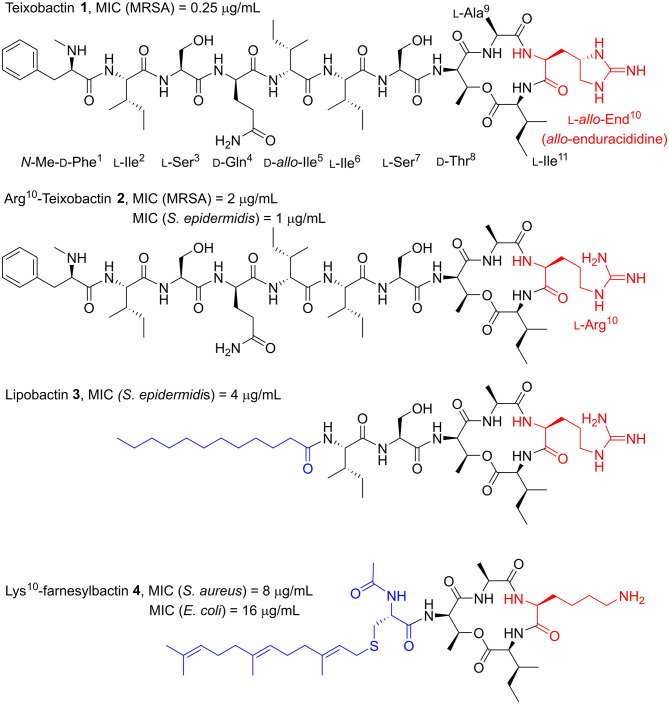
Structures of teixobactin 1 and teixobactin analogs; Arg10-teixobactin 2, lipobactin 3, and Lys10-farnesylbactin 4. Examples of most relevant MICs from the literature are shown above each structure. Yang H. et al. (2016), Girt et al. (2018), Zong et al. (2018) The End10, Arg10 and Lys10 substitutions (red) and the lipid moieties of lipobactin 3 and farnesylbactin 4 (blue) are highlighted.